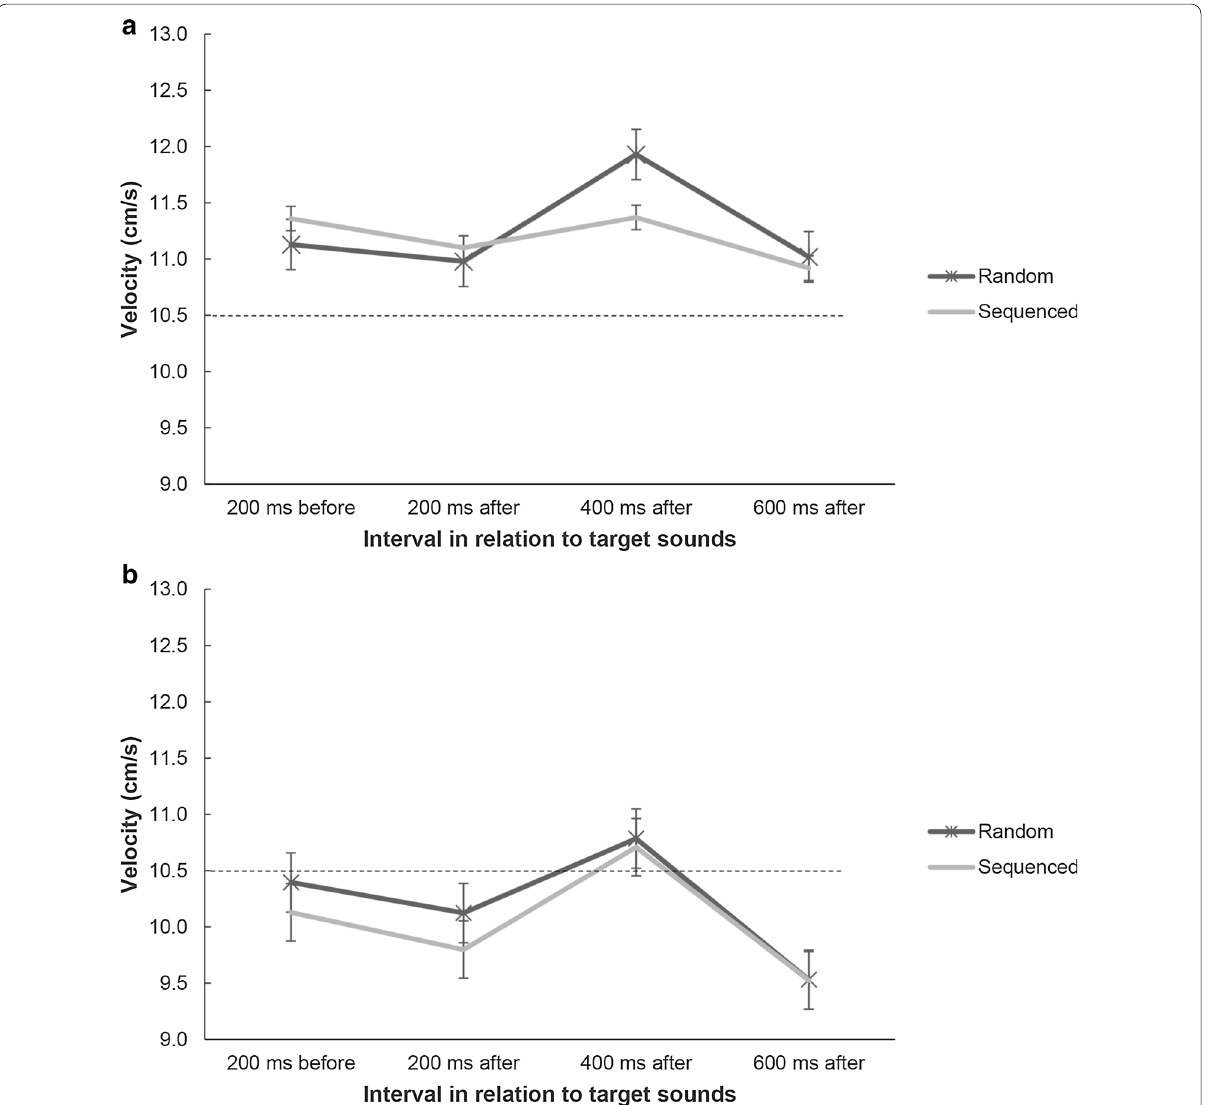
Fig. 7 Tracking velocity analyses in Experiments 2a ( a ) and 2b ( b ). Baseline tracking velocity (200 ms before the occurrence of a target sound) was compared against 200 ms, 400 ms, and 600 ms after the sound onset. The dashed horizontal line represents the constant target velocity (10.5 cm/s). Error bars show standard